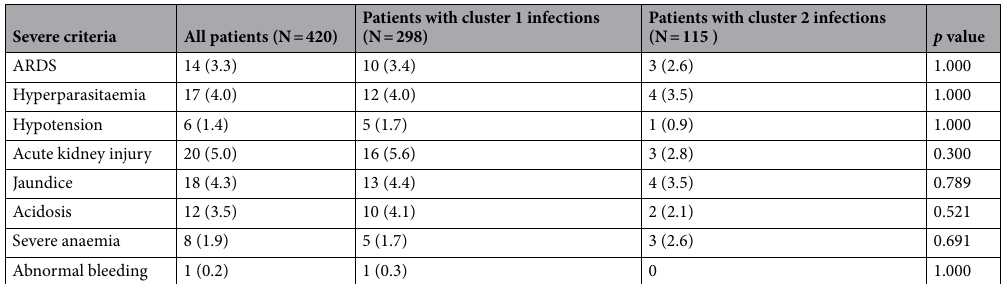
Table 5. Overall distribution of severe criteria among patients infected with P. knowlesi . Data are presented as no. (%). Hyperparasitaemia is defined as > 100,000 parasites/μL; severe anaemia defined as count > 20,000/μl; hypoglycaemia—serum glucose < 2.2 mmol/l; acidosis—base deficit > 8 meq/l or plasma bicarbonate < 15 mmol/l or venous plasma lactate ≥ 5 mmol/l; ARDS (acute respiratory distress syndrome)— respiratory rate > 30 breaths/minute plus oxygen saturation < 92% on air and/or pulmonary infiltrates on chest radiograph. p value is between cluster 1 and cluster 2. Abnormal bleeding involved splenic bleeding.